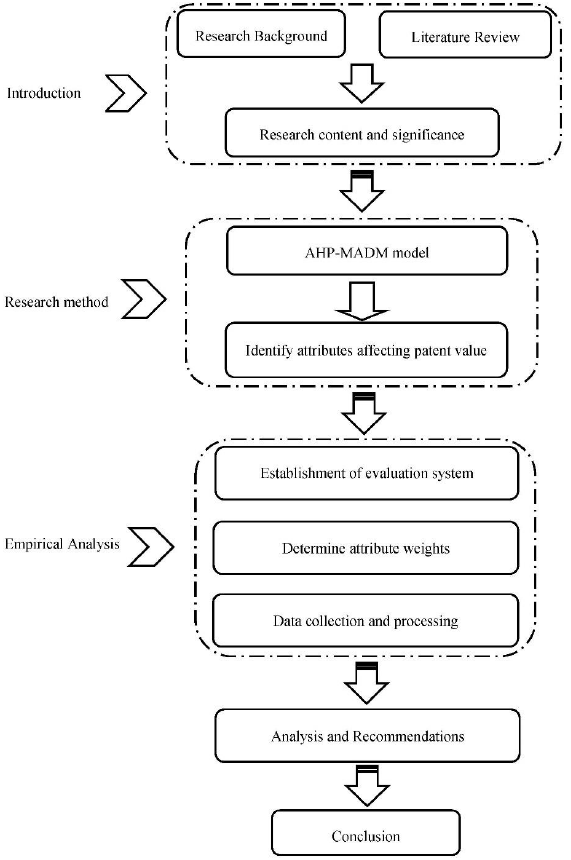
Figure 2. Structure of the article.